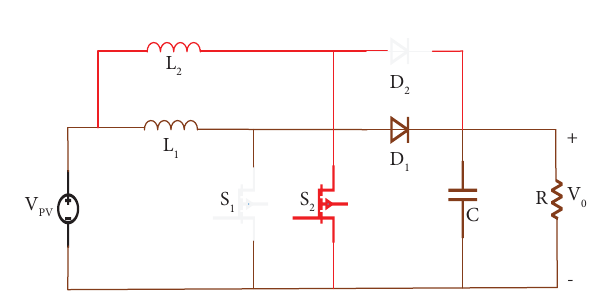
Figure 6: Mode-3: S1-OFF, S2-ON.